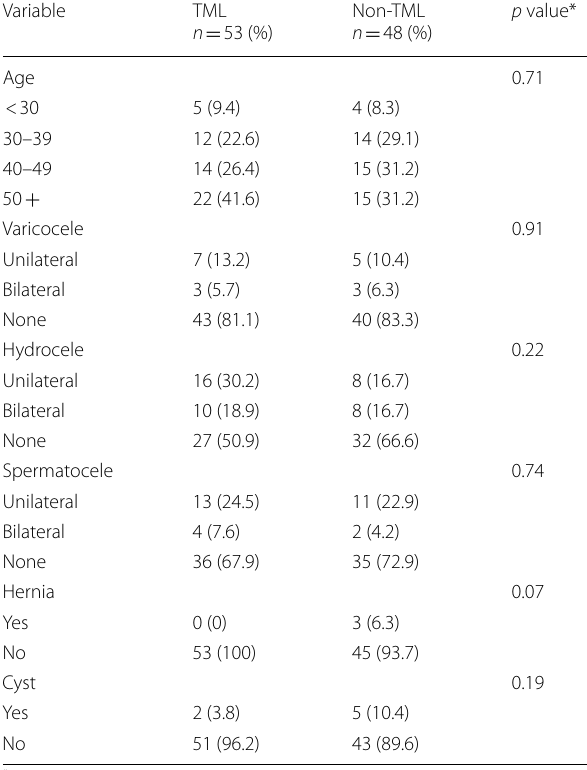
Table 2 Association between TML and non-TML